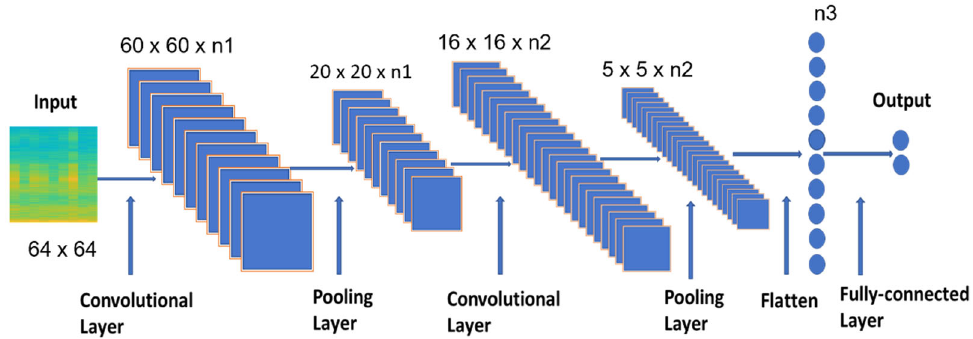
Figure 7. A basic CNN architecture with two Convolutional layers, two Pooling layers, a Fully connected layer, and an output layer with two possible outcomes, where n 1 and n 2 are the number of channels for layer 1 and layer 2 respectively, and n 3 is the number of inputs to the Fully connected layer. (Adapted from [41].) The network takes a STFT spectrogram (as a 64 × 64 image) as input, and outputs one of two classes–Queen Present or Queen